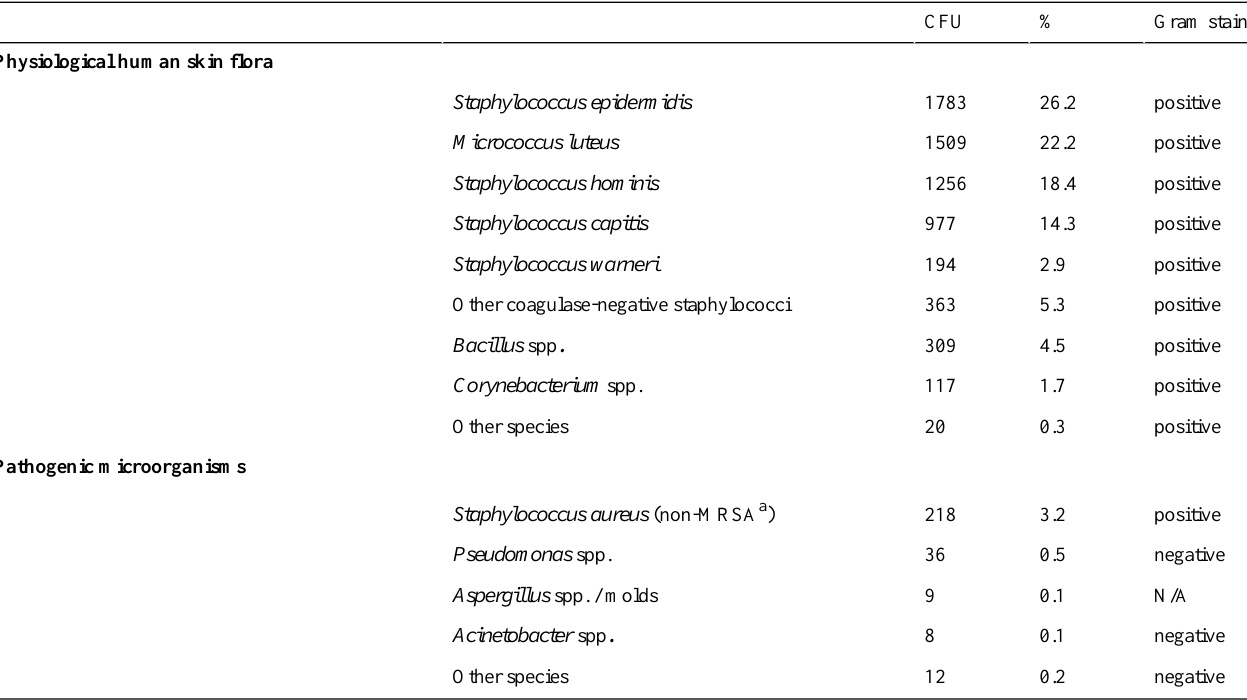
Table 2. Distribution of species of microorganisms from the surface of the iPads on initial arrival of the devices at the laboratory (shown as cumulative number of colony forming units from 20 tablet PCs; n=6811).